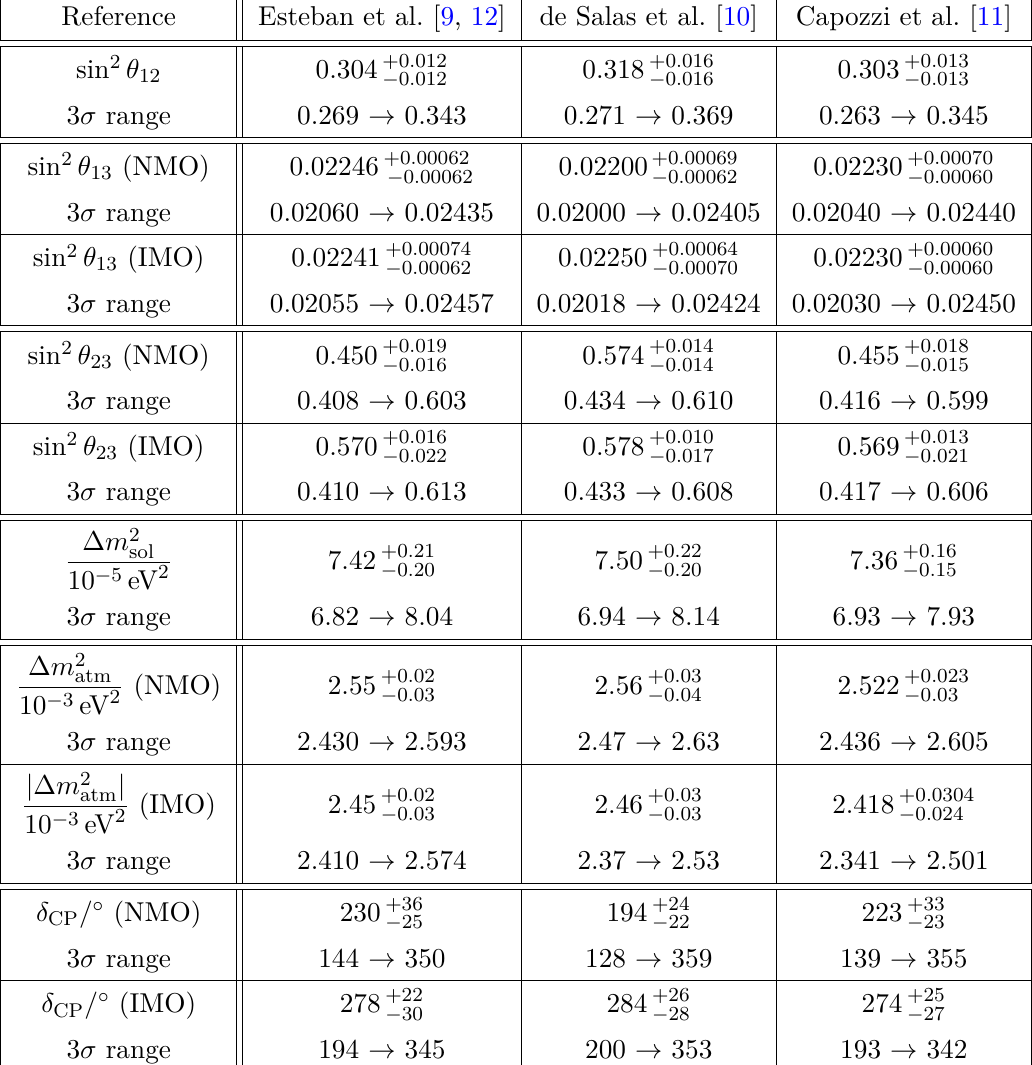
Table 5 . Best-fit values, ± 1 σ uncertainties, and 3 σ allowed ranges of the three-flavor neutrino oscillation parameters from the three global fit analyses of world neutrino data [9–12]. For Esteban et al. [9, 12], ∆ m 2 stands for ∆ m 2 (∆ m 2 ) for NMO (IMO). For de Salas et al. [10] and Capozzi atm 31 32 et al. [11] ∆ m 2 signifies ∆ m 2 for both NMO and IMO. Note that for Capozzi et al., we estimate atm 31 the values of ∆ m 2 for both NMO and IMO using the relation ∆ m 2 31 ∆ m 2 = m 2 + m 2 ) / 2 − ( m 2 3 1 1